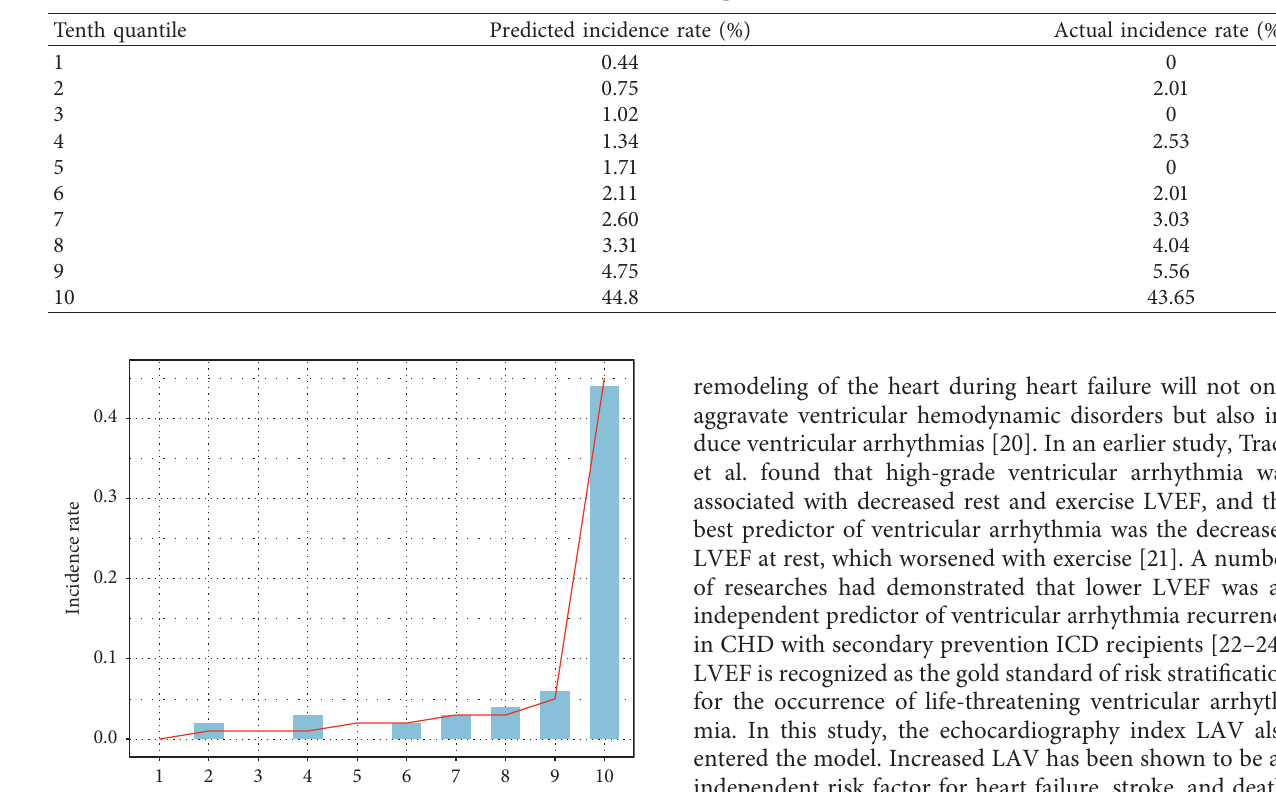
Figure 6: ROC curve of verification Table 6: Actual incidence rate and predicted incidence rate.